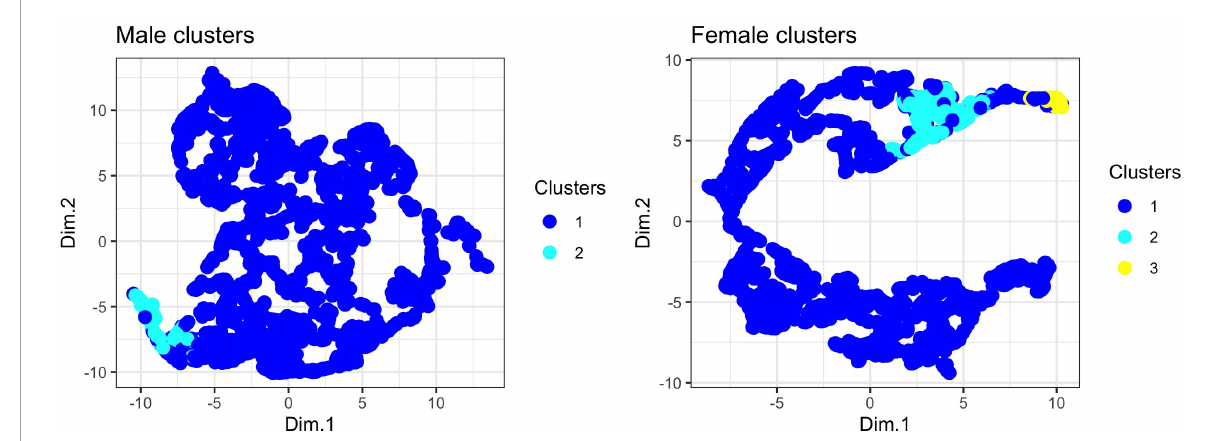
FIGURE5 UMAP projections for male and female tarsier duet contributions. For each note in the tarsier duet, we input a feature vector consisting of the four features estimated into the UMAP algorithm, which returned two-dimensional embeddings (Dim. 1 and Dim. 2) used to visualize clustering of note types. Each point represents a single note from the tarsier duet. The color indicates cluster assignment by the random forest algorithm (see text for